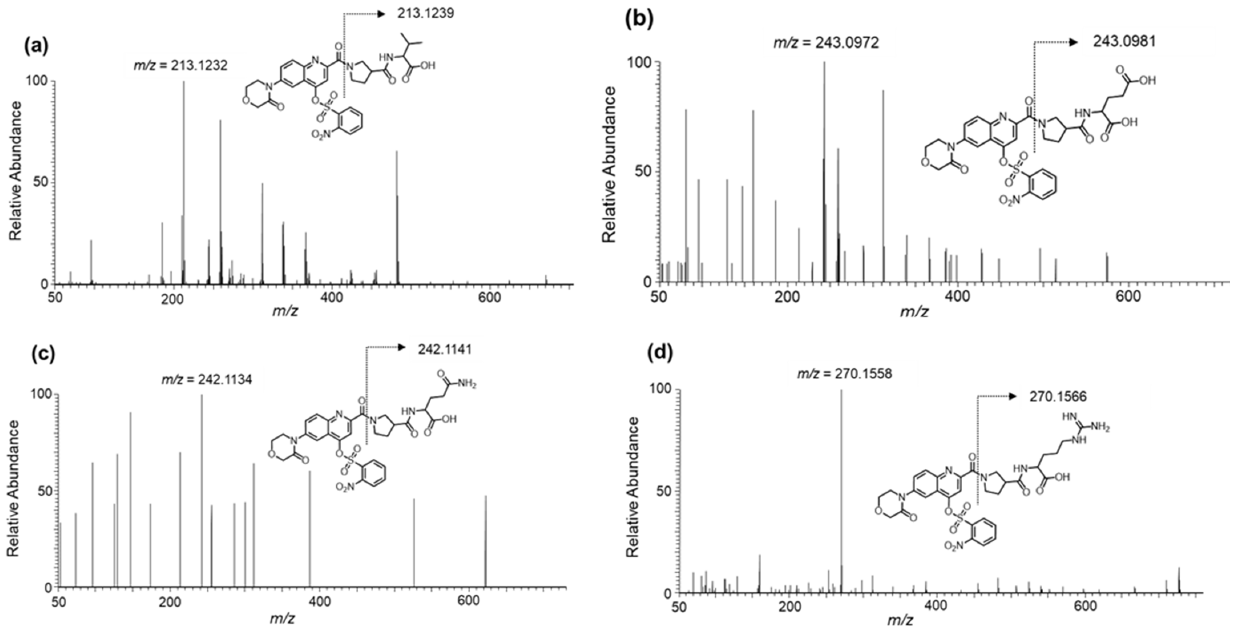
Figure 3. MS/MS spectra of derivatized amino acids: ( a ) Val, collision energy (CE) 30%; ( b ) Glu, CE 30%; ( c ) Gln, CE 30%; and ( d ) Arg, CE 30% with Ns-MOK-( S )-Pro-OSu using ESI (+) mode.